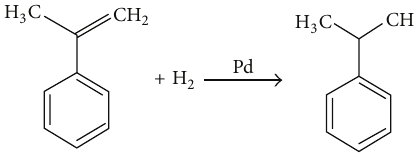
Figure 1: Hydrogenation reaction of AMS.